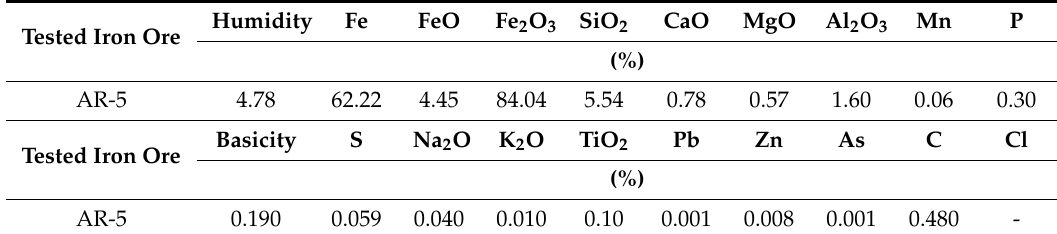
Table 3. Chemical composition of the tested iron ore used in the experiment.